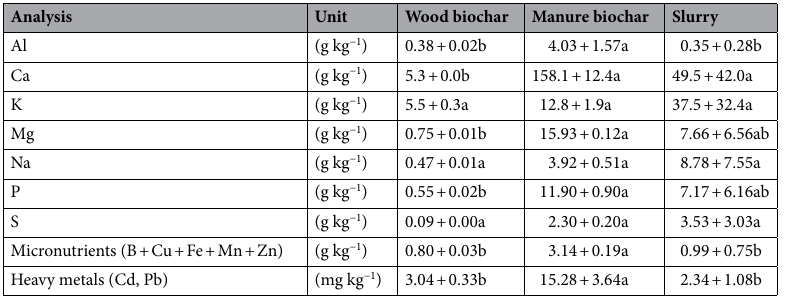
Table 2. Total nutrients measured in acid-digested (HClO 4 + HNO 3 ) amendments used for the greenhouse trial ± the standard deviation. Letters indicate significant differences between amendments using a one-way anova (p < 0.05; n = 3).